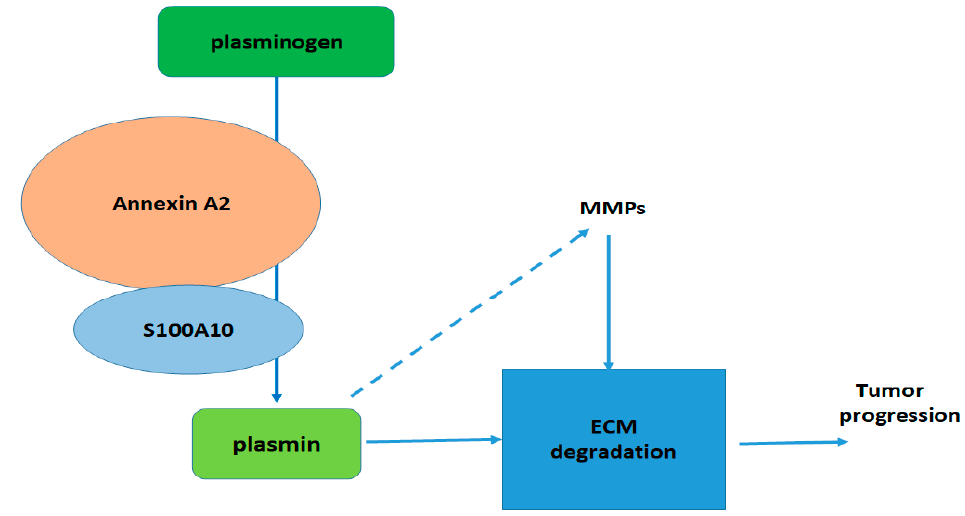
Figure 1. Role of S100A10 in tumor progression.